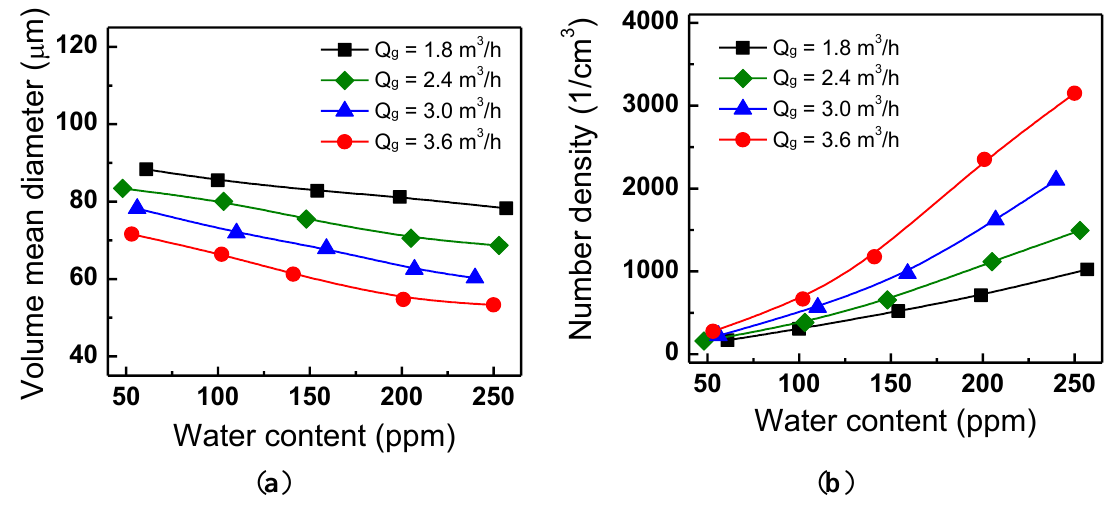
Figure 6a,b show distributions of size and cumulative volume of water droplets measured